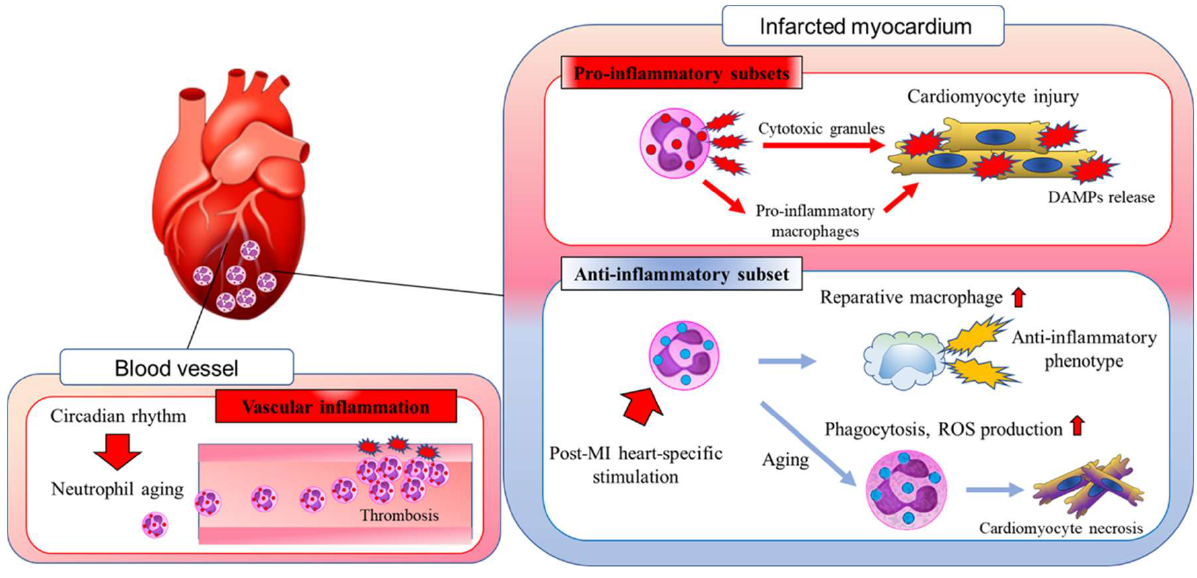
Figure 1. In response to myocardial infarction (MI), neutrophils migrate into the damaged myocar- dium. In the post-MI heart, neutrophils amplify cardiac inflammation by releasing cytotoxic gran- ules and stimulating the differentiation of proinflammatory macrophages. During the wound heal- ing phase, the heart-specific microenvironment induces neutrophil aging, which results in the reso- lution of cardiac inflammation. Neutrophils also contribute to the differentiation of alterna- tively activated reparative macrophages in the post-MI heart. Neutrophil aging is regulated by the circadian rhythm, but the local microenvironment also has a marked effect on cardiovascular home- ostasis. DAMPs, damage-associated molecular patterns; MI, myocardial infarction; ROS, reactive oxygen